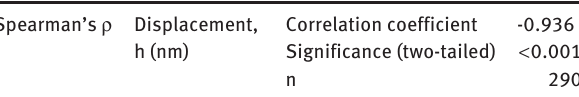
Table 2 Spearman ’ s ρ value for the correlation between E and h.